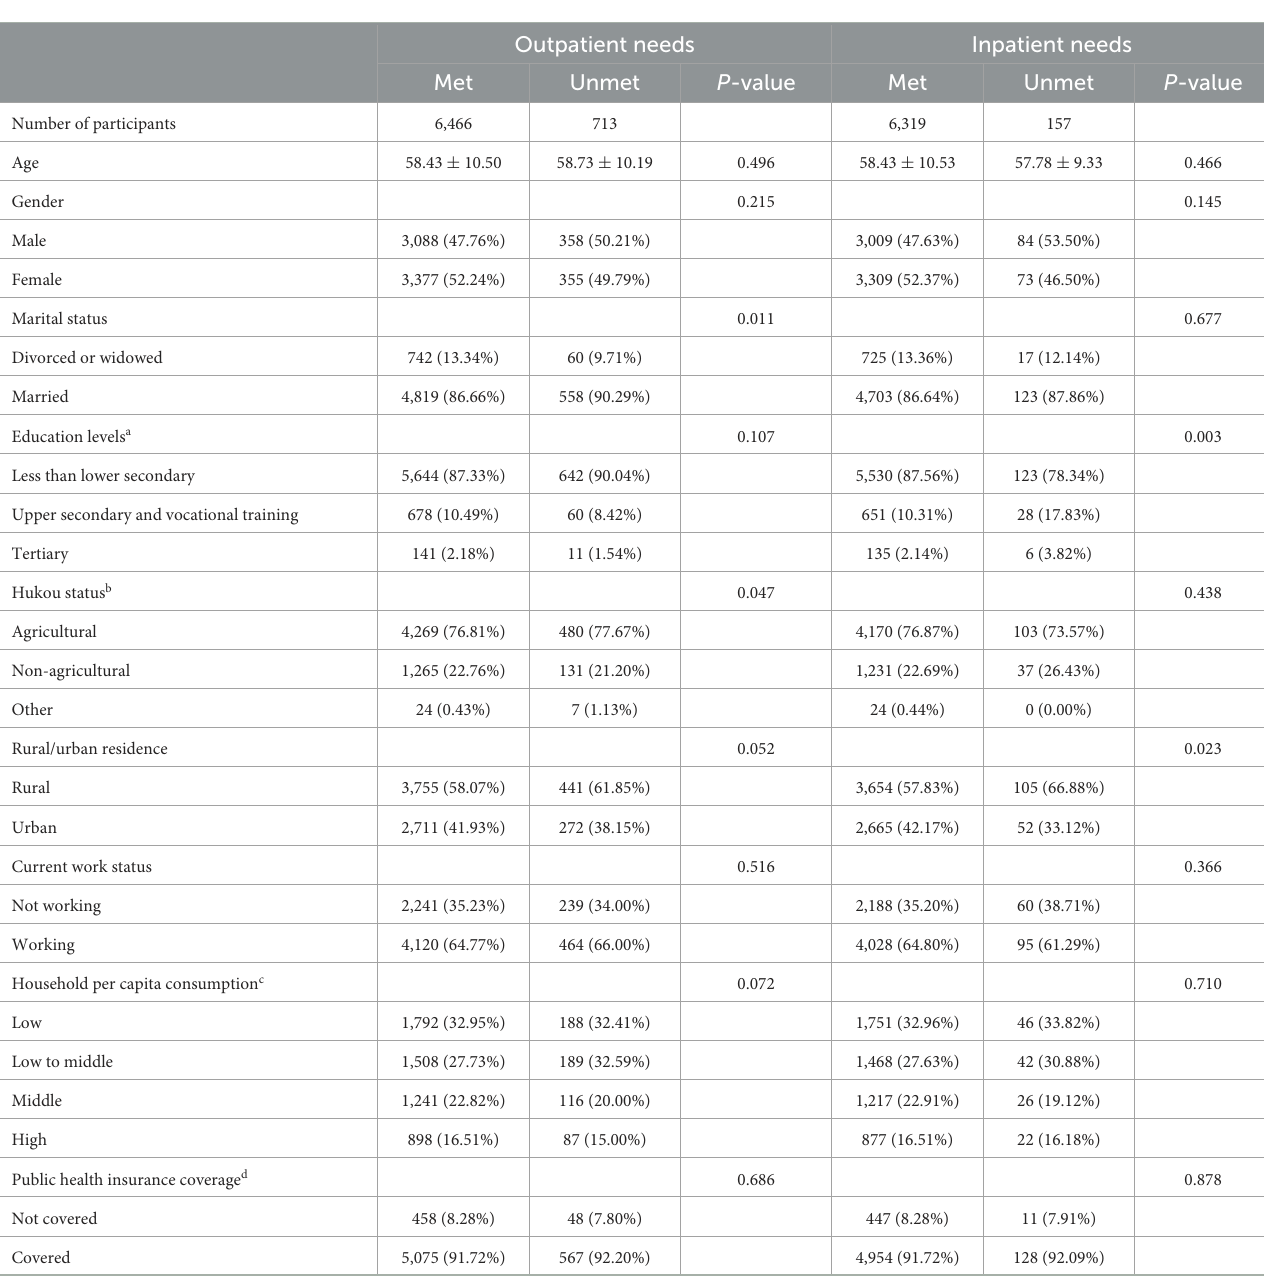
TABLE 1 Baseline